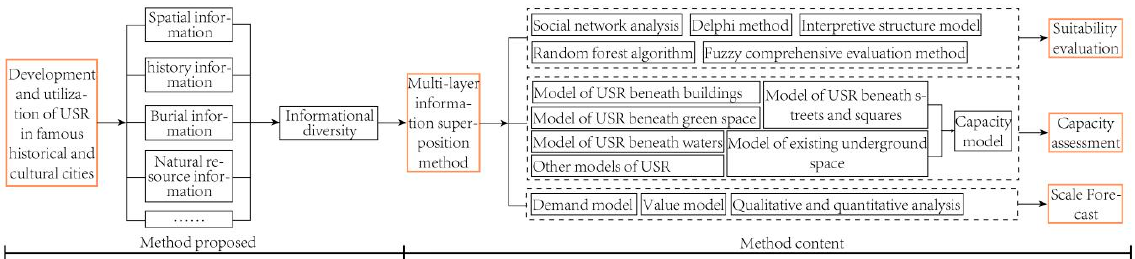
Figure 2. Origin of multi-layer information superposition method.